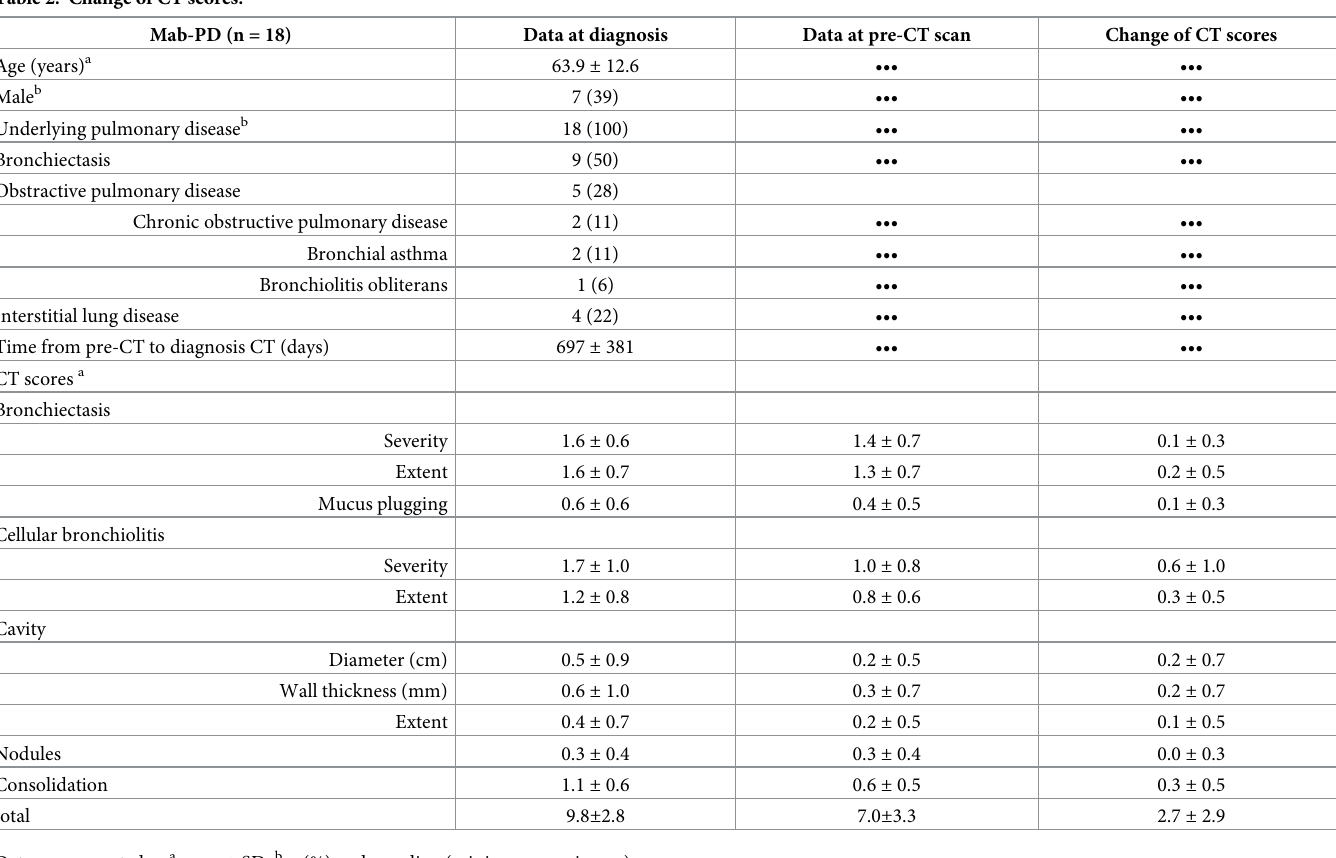
Table 2. Change of CT scores.